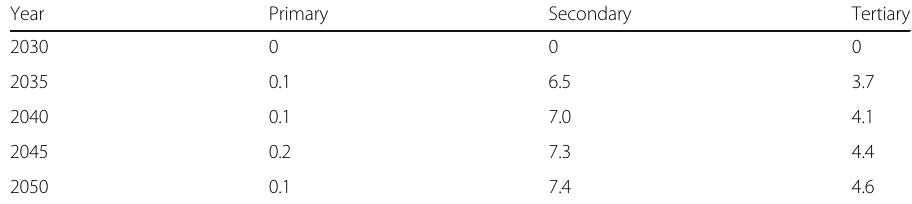
Table 8 Case study – Impact on Gross Value Added by sector p.a. (million € ), EU28 + 2, difference